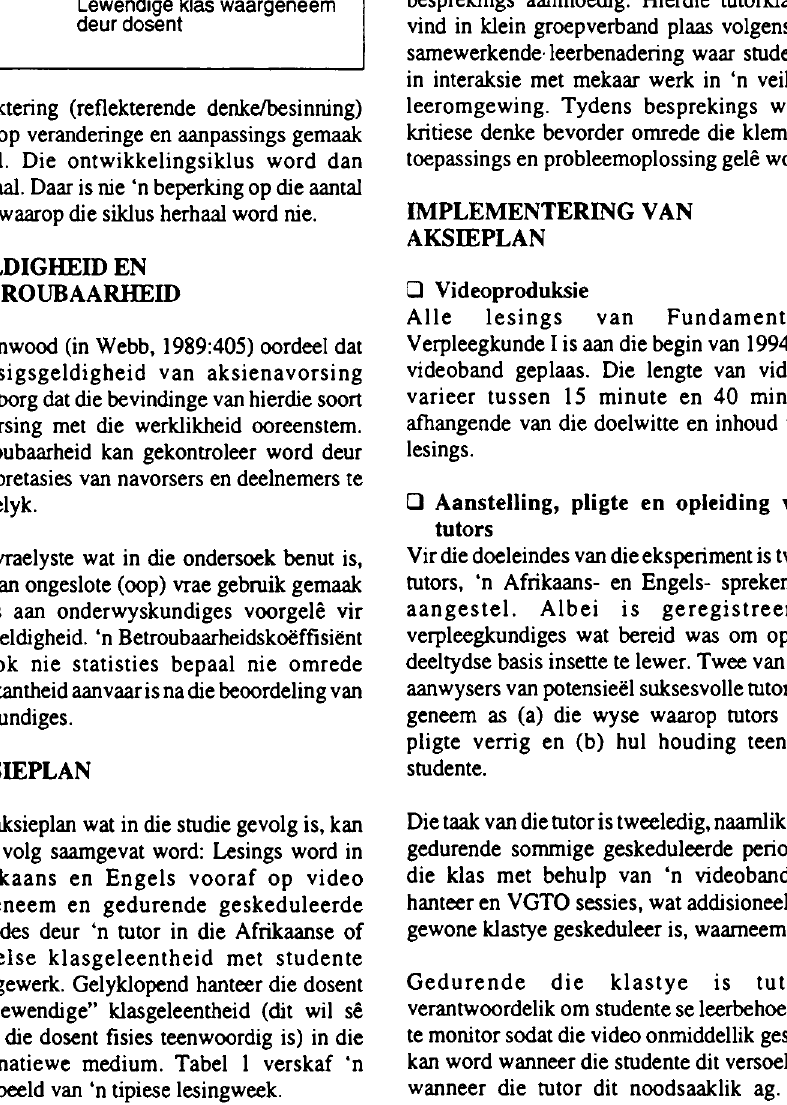
FIGUUR 1:Die aksie navorsingsbenadering (Kemmis & McTaggart,